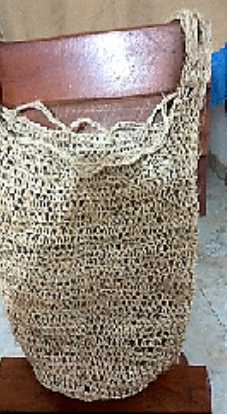
Figure 5. “Mochilón” knitted by an Arhuaco girl. Photo by Dwrya Izquierdo (2015).